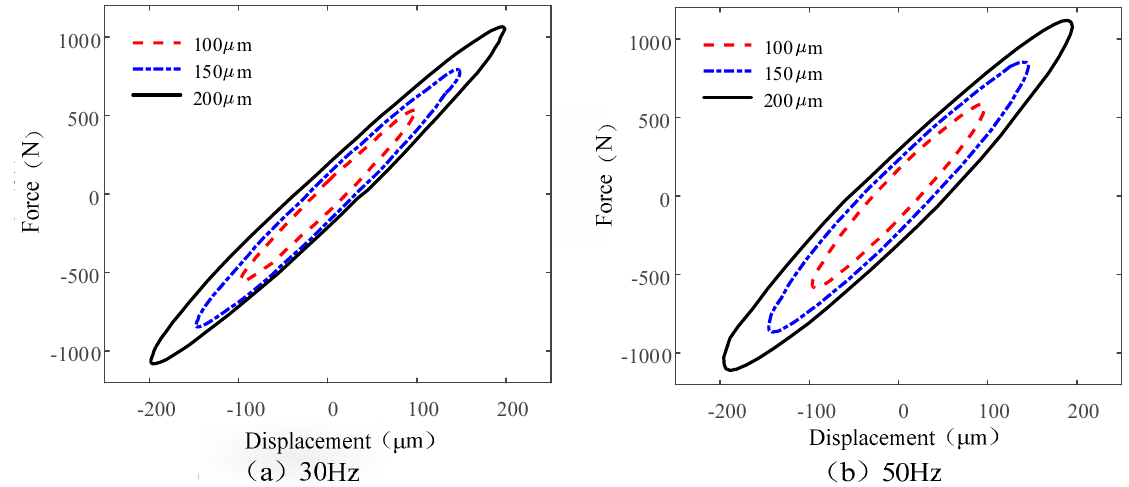
Figure 7. The hysteresis curves of specimen Y02 at the same frequency with different displacements: ( a ) 30 Hz, ( b ) 50 Hz.